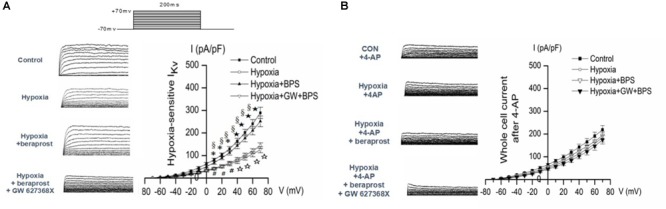
Whole-cell K+ current (IK) and EM of PASMCs were measured by whole cell patch clamp in normoxia (control) and hypoxia setting with or without treatment as shown. (A) In the absence of the Kv channel blocker 4-AP. ∗p < 0.05, ⋆p < 0.01 Hypoxia vs. Control. §p < 0.05 Hypoxia + BPS vs. Hypoxia. #p < 0.05, ☆p < 0.01 Hypoxia + GW + BPS vs. Hypoxia + BPS. (B) In the presence of the Kv channel blocker 4-AP. ∗p < 0.05 Hypoxia vs. Control.